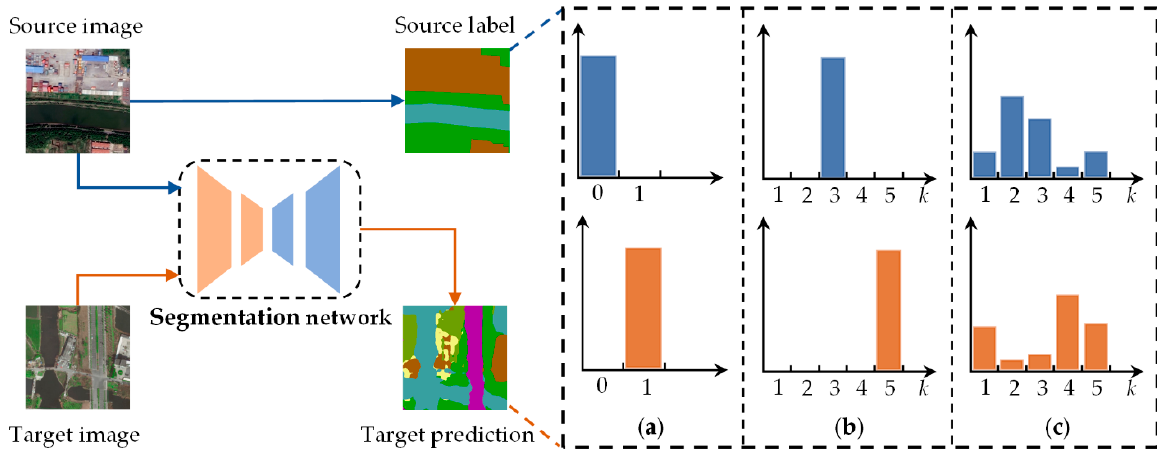
Figure 3. Illustration of domain label extraction module using different strategies. ( a ) Binary label. ( b ) Category-wise hard label. ( c ) Category-wise soft label. The elements drawn in blue present the source flow, while the orange ones indicate the target flow.